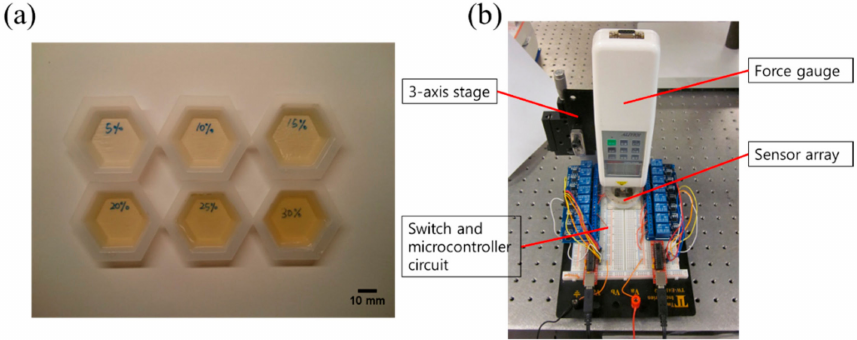
Figure 3. ( a ) The fabricated test samples with di ff erent weight ratios; ( b ) The experimental setup for the stress-strain measurement and force-sensing